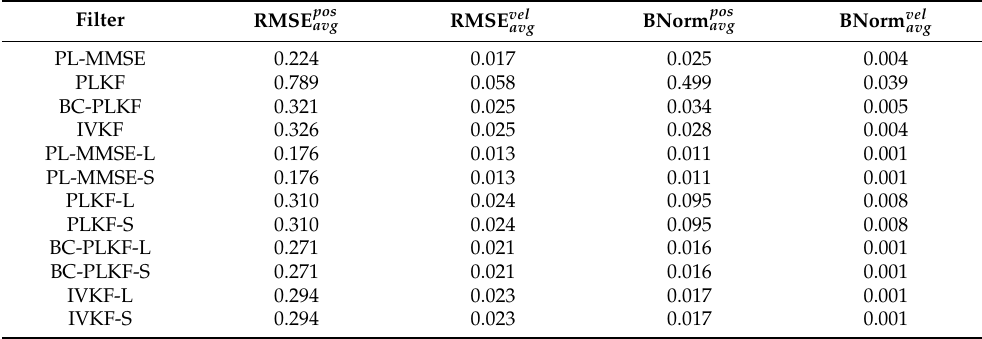
Figure 15. Time-averaged RMSEs, BNorms and bearing noise standard deviation at V = 0.2 m/s for the four algorithms combined with the second-order approximation method. Table 9. RMSE pos avg ,RMSE vel avg ,BNorm pos avg and BNorm vel avg of different filters for σ θ = 7 ◦ at V = 0.2 m/s on the arc